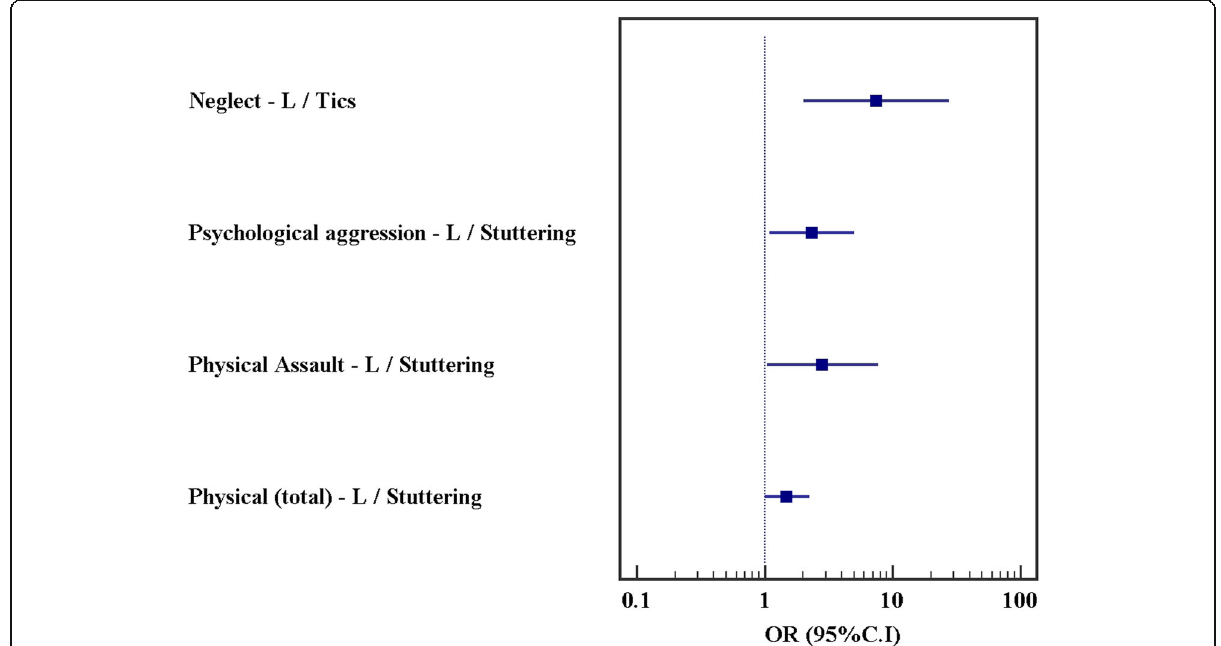
Fig. 3 Logistic regression for predictor variables significantly affecting psychiatric diagnostic categories